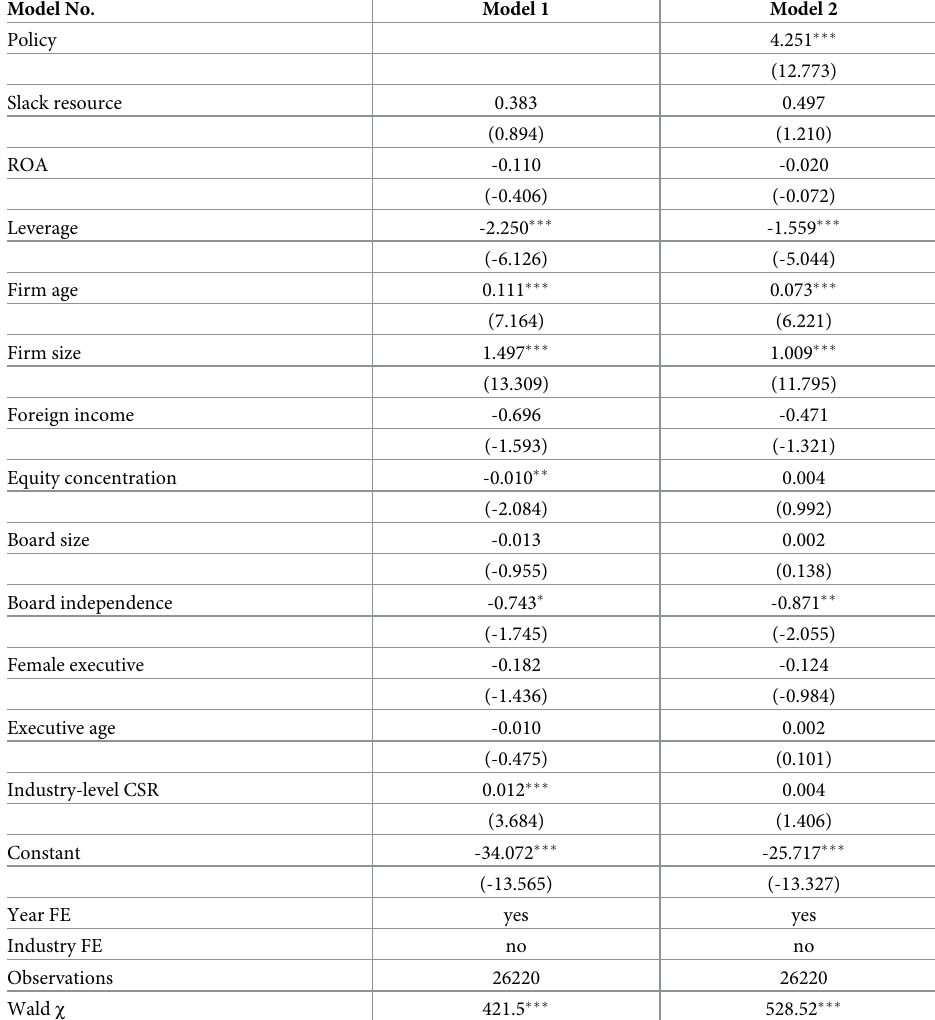
Table 3. Probit estimates for Heckman first-stage